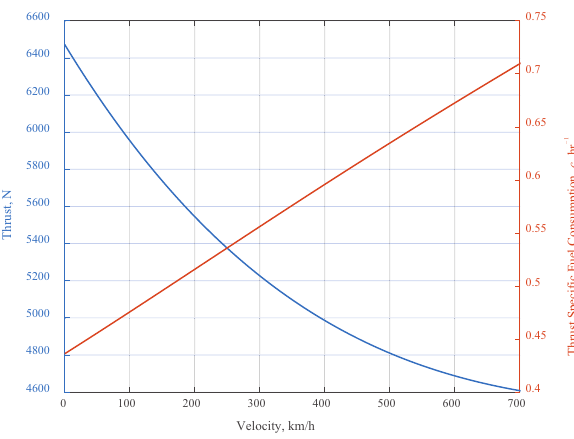
Figure 1. Thrust and TSFC vs. velocity at 9,144